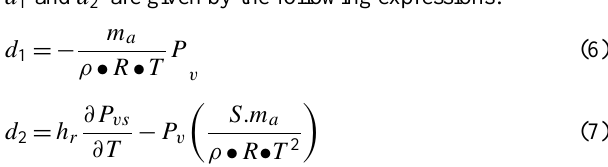
Figure 2b. Thermal properties of the Beaver Creek Sand (Gitirana et al. 2005) Fig. 2b. Thermal properties of Beaver Creek Sand (Gitirana et al.,